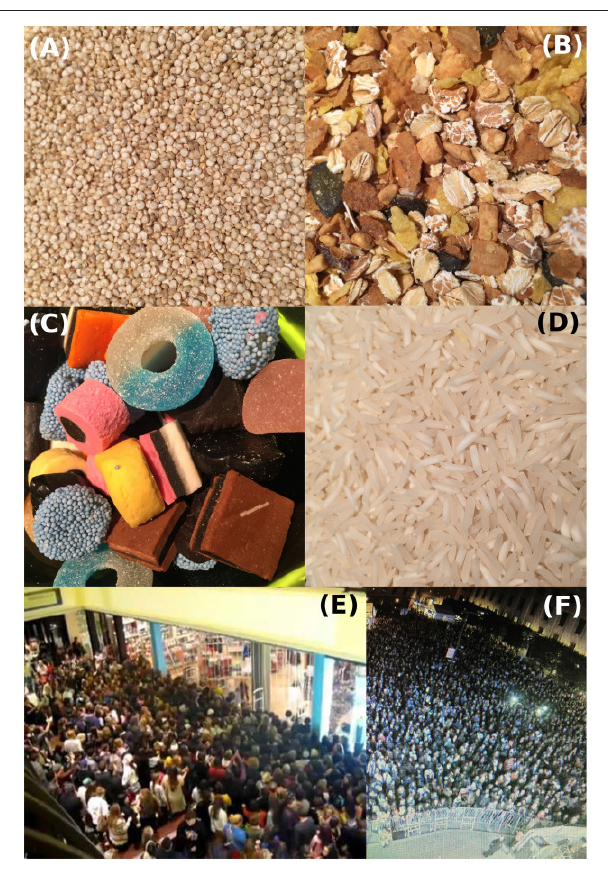
FIGURE 1 | Common examples of non-human granular media including (A) quinoa, (B) muesli, (C) mixed candy, and (D) rice, compared to high-density human crowds at (E) a Black Friday sales event and (F) an outdoor concert. Similarities with the former inspires an analysis of the latter. This collection of images represents a cross-section of the various geometries, heterogeneities, and interactions that fall within the purview of granular media